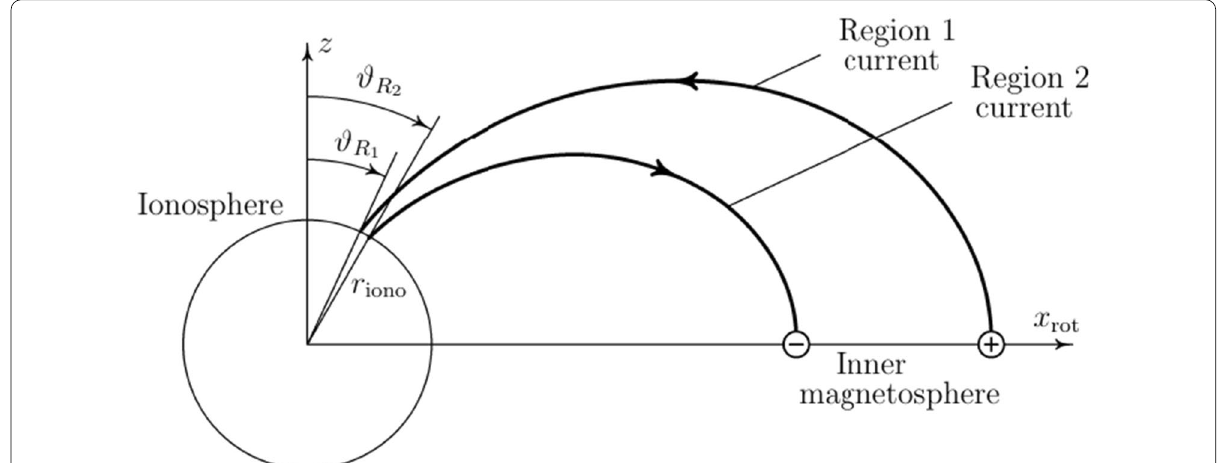
Fig. 21 The geometry considered to derive the magnetic field generated by Region 1 and Region 2 field-aligned currents connecting the northern polar ionosphere and the inner magnetosphere. The currents flow in the meridional plane ϕ = α . The poleward Region 1 and equatorward Region 2 have colatitudes ϑ R and ϑ R , respectively. The electric circuit model designed in this paper considers also the second pair of Region 1 and Region 1 2 2 field-aligned currents connecting the southern polar ionosphere and the inner magnetosphere (not shown in the